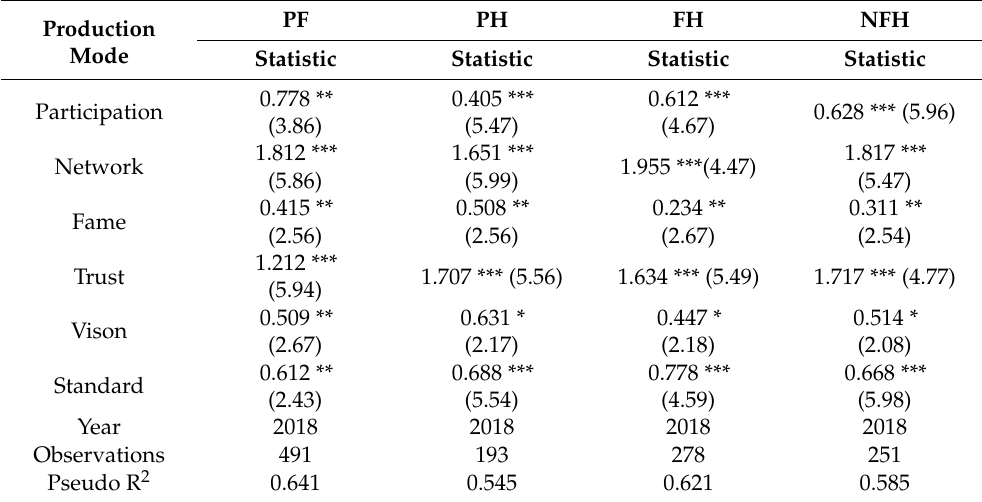
Table 6. Subjective well-being of farmers and herdsmen under four production